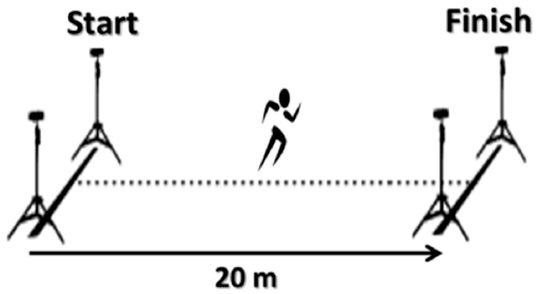
Figure 3. 20 m sprint test.